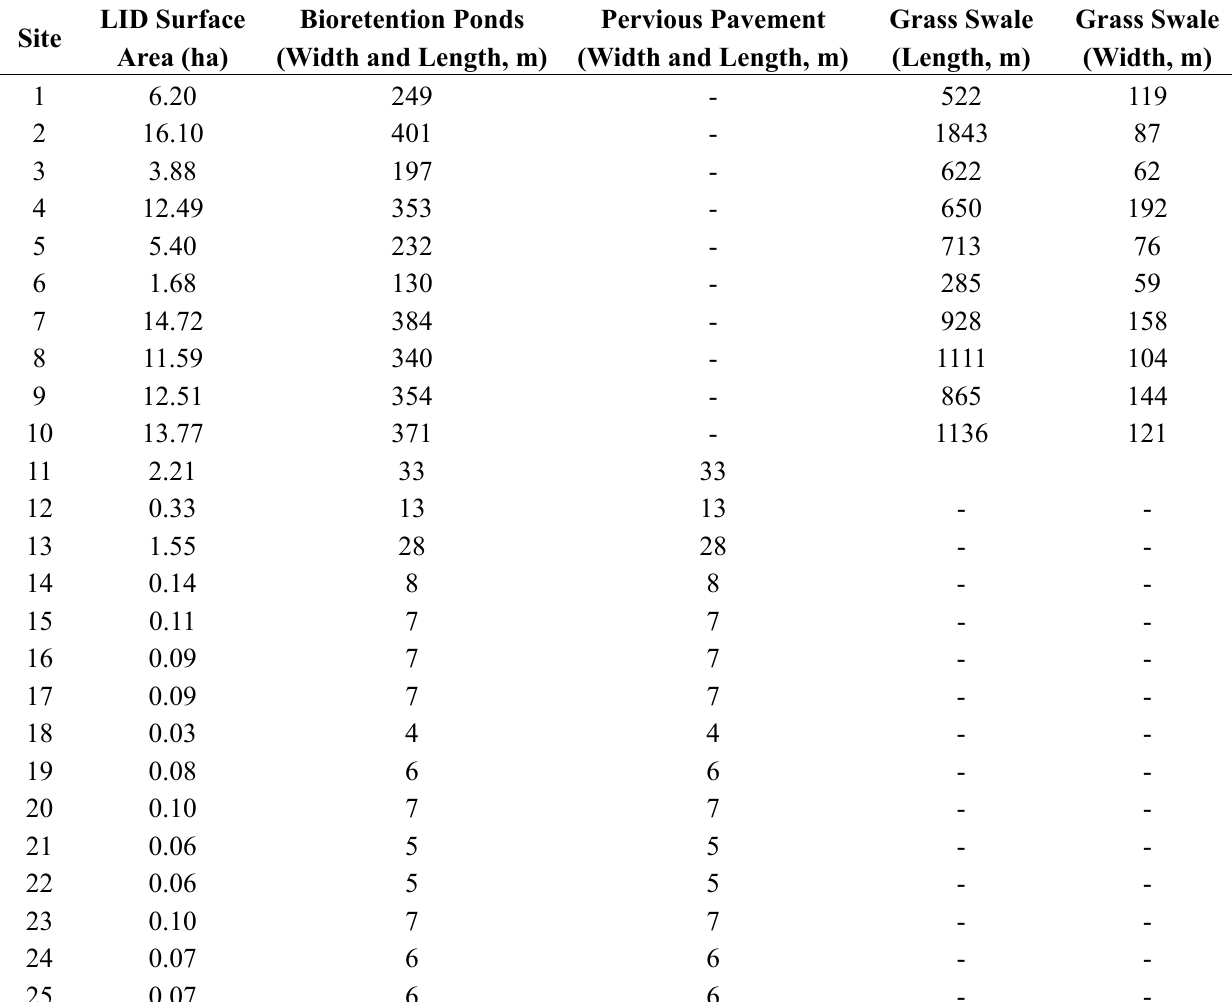
Table 4. LID dimensions for potential sites in Yuanshanyan